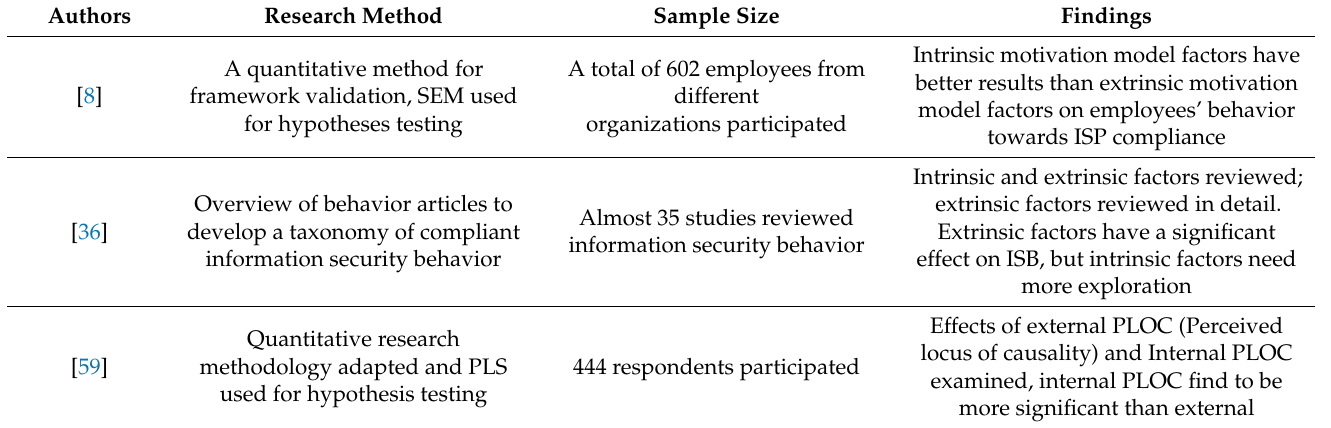
Table 5. Studies on intrinsic/extrinsic motivations and